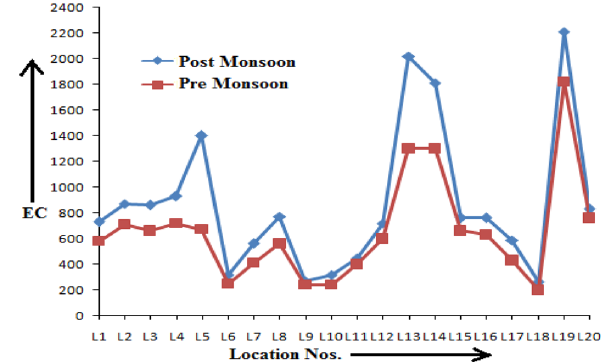
Fig. 4 Spatio-temporal variation in EC value in the study area